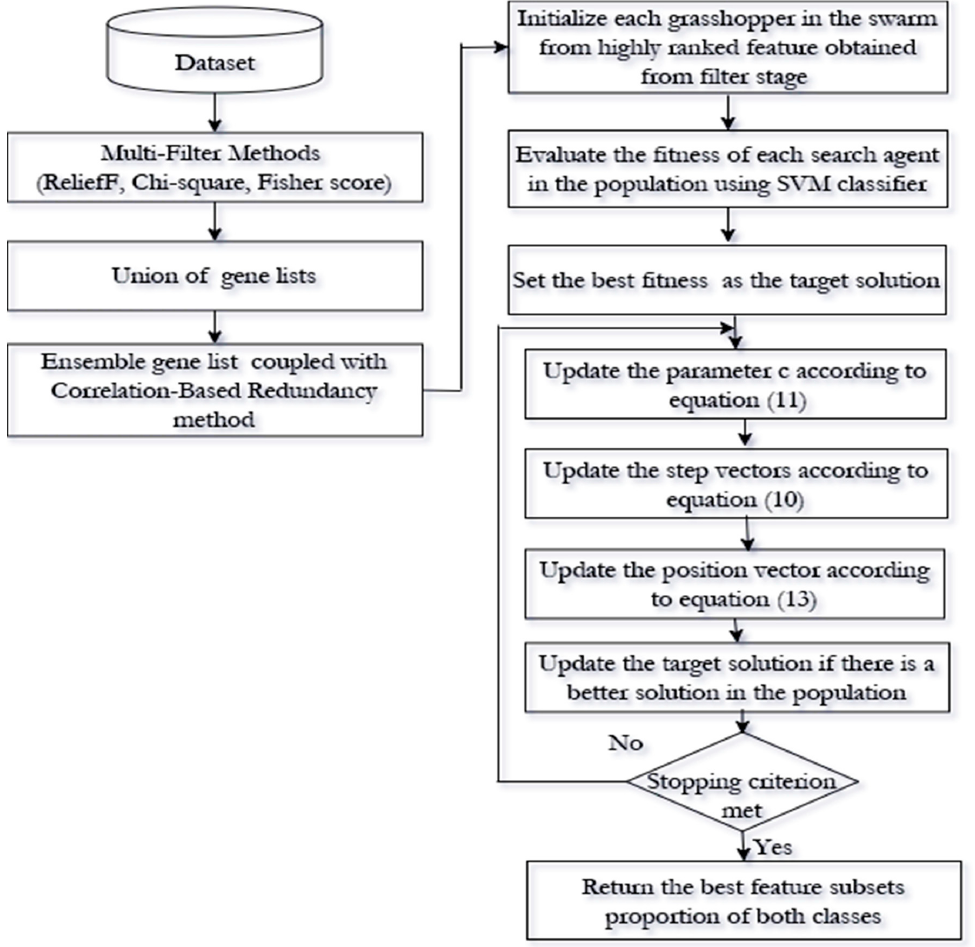
Figure 1. Schematic illustration of the proposed approach for high dimensional imbalanced data set using feature selection.